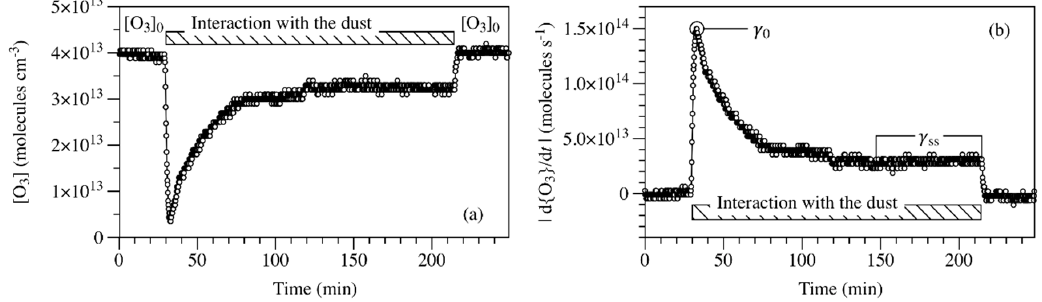
Figure 1. ( a ) Typical profile of the uptake of 4 × 10 13 molecule cm − 3 O 3 (i.e., 1.6 ppm) displayed by ozone concentration variation as a function of time, on 100 mg Gobi dust sample at room temperature and atmospheric pressure using the fixed bed reactor; [O 3 ] 0 is the initial inlet ozone concentration measured as ozone was directed through the bypass line without interacting with the dust samples. ( b ) Corresponding absolute ozone molecule flow taken up by the 100 mg Gobi dust sample, expressed in molecule s − 1 ; the datasets used to calculate γ 0 and γ ss are indicated.